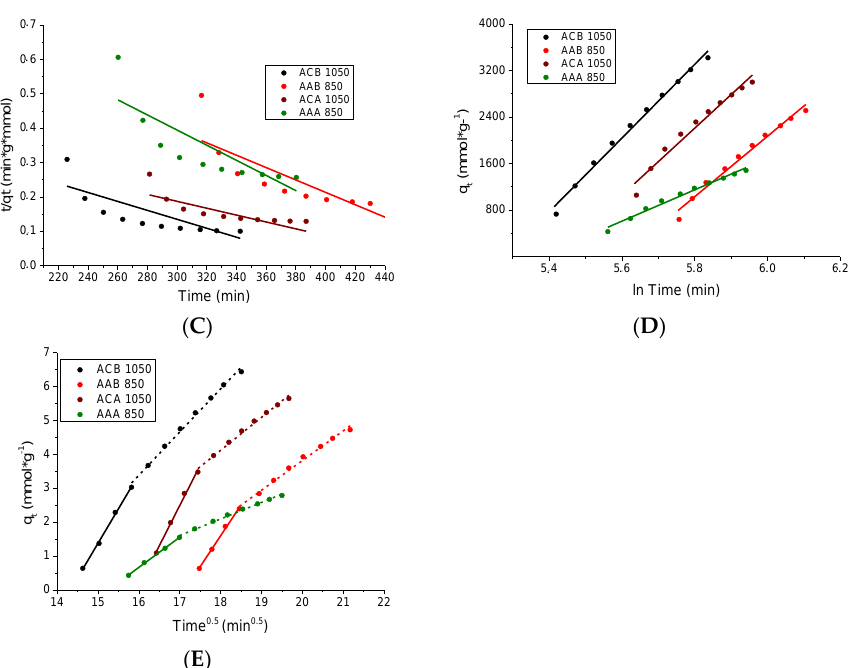
Figure 8. Results of applying the kinetic models to the data obtained from CO 2 adsorption on the surface of the aerogels: ( A ) Pseudo first order; ( B ) Modified Pseudo first modified order; ( C ) Pseudo second order; ( D ) Elovich model and ( E ) Intra-particle diffusion.